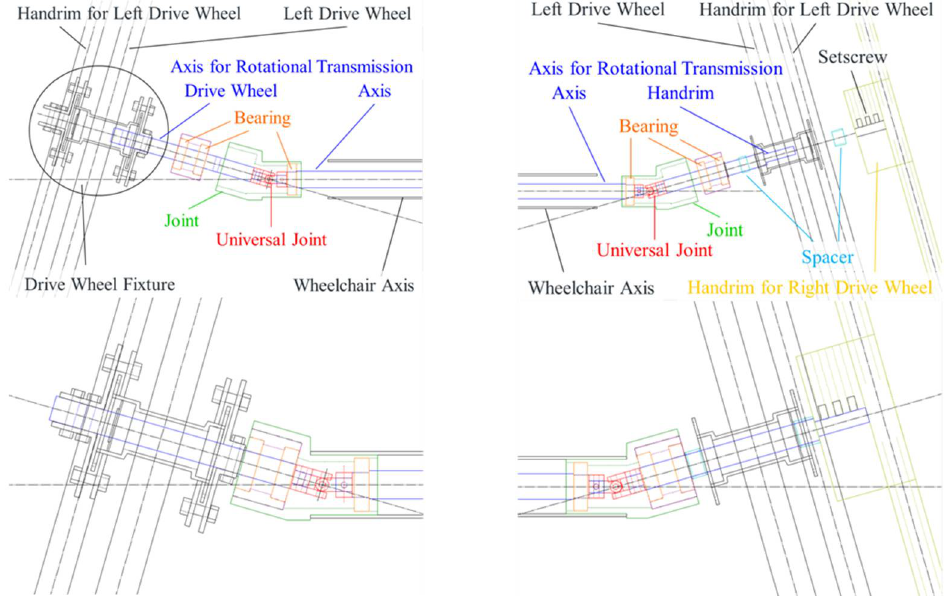
Figure 2. The structure of the DFTA using the universal joints. This figure is in condition of seeing a wheelchair from